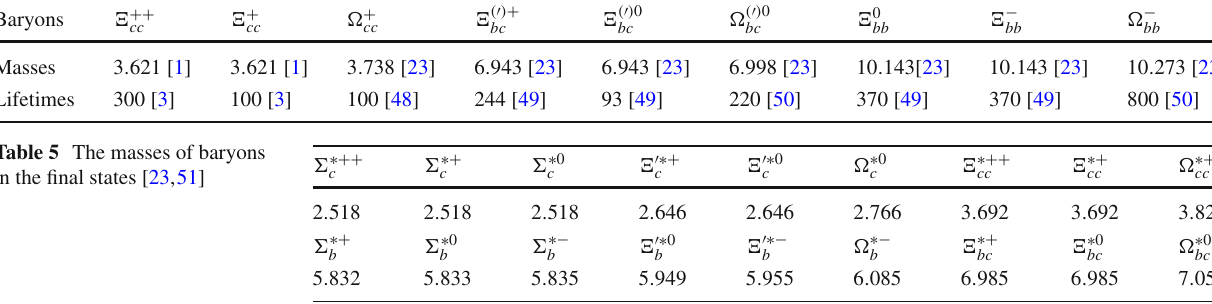
Table 4 Masses (in units of GeV) and lifetimes (in units of fs) of doubly heavy baryons Baryons